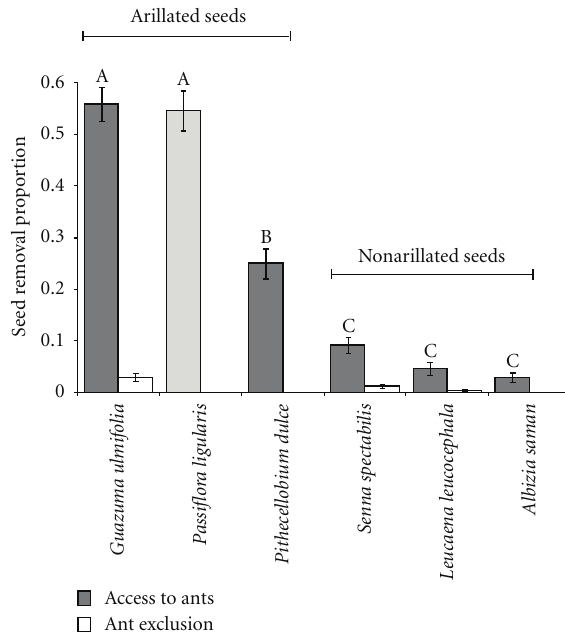
Figure 1: Mean ( ± SE) removal of nonmyrmecochorous seeds by ants in cattle grasslands. Letters above columns show di ff erent seed preference groups by ants after a Newman-Kewls test ( α =